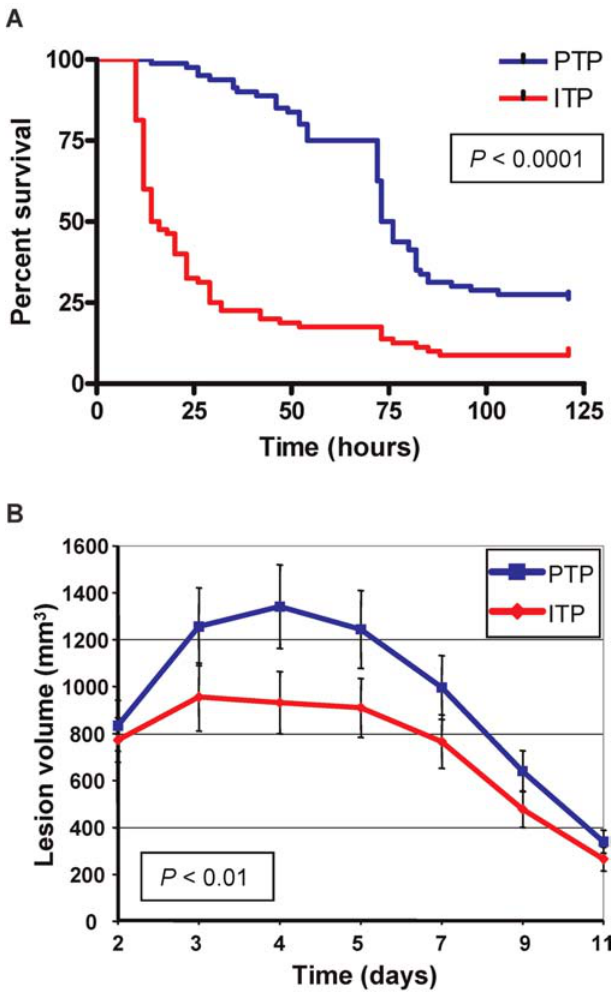
Figure 3. Differential Virulence of ITP and PTP GAS in Mouse Models of Invasive Disease (A) ITP GAS are significantly more virulent than PTP GAS in a mouse model of bacteremia ( p , 0.0001, logrank test). Female CD-1 mice were injected intraperitoneally with 2.5 3 10 7 CFU of GAS and lethality was monitored. Four ITP and four PTP strains were each used to infect 20 mice. Survival curves were generated by pooling data from mice infected with GAS strains of the same transcriptome profile. (B) PTP GAS produce significantly larger lesion volumes than ITP GAS in a mouse soft-tissue infection model ( p , 0.01, mixed-model repeated- measures analysis). Female Crl:SKH1-hrBR mice were injected subcuta- neously with 1 3 10 7 CFU of GAS and monitored for skin lesion formation. Shown are the average lesion volumes ( 6 standard error of the mean) of mice pooled together based on the transcriptome profile of the infecting strain. Fifteen mice were infected per GAS strain, with four ITP and four PTP strains being used. DOI: 10.1371/journal.ppat.0020005.g003 PLoS Pathogens |